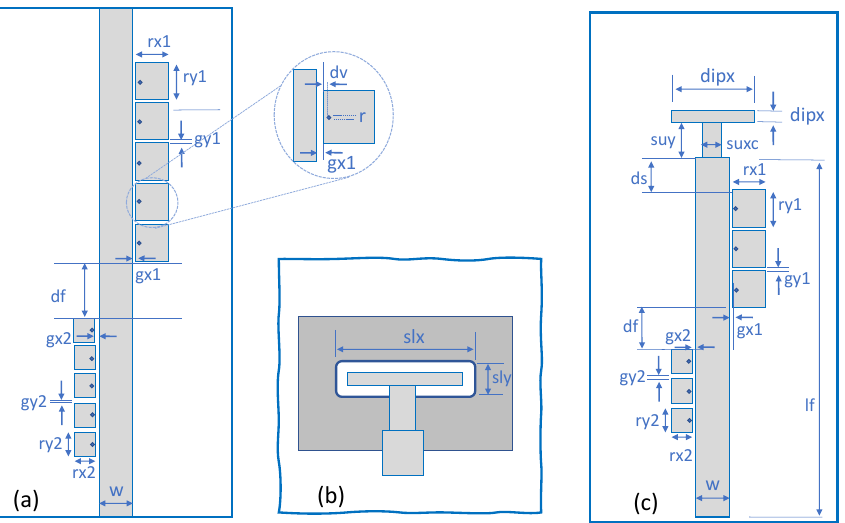
Figure 4. Geometry of the proposed filtering structures (microstrip printed layer) and main parame- ters. ( a ) Dual-band EBG filter. ( b ) Slot antenna and T-shape feeding line section. ( c ) Filtering